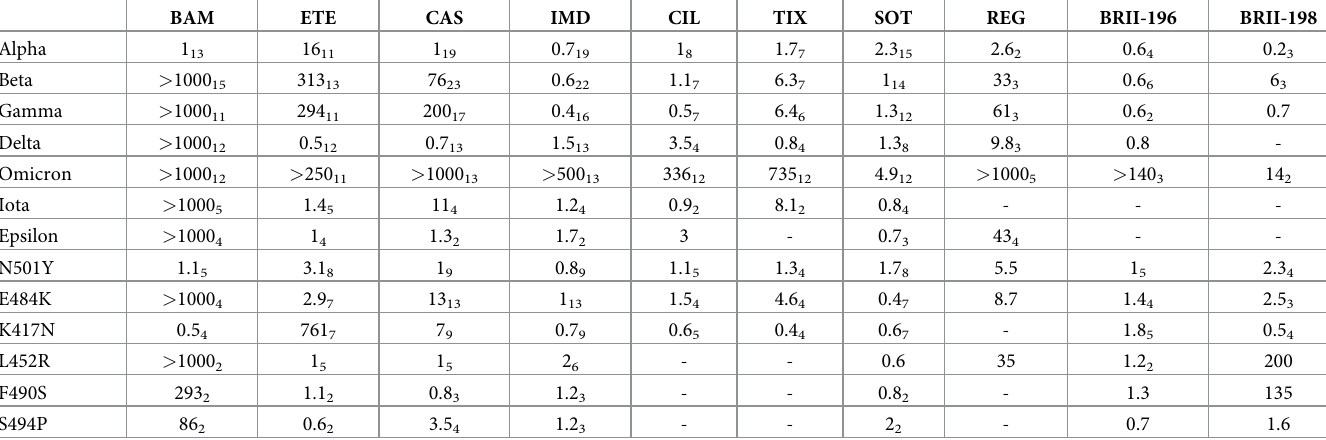
mAbs. In CoV-RDB, mAbs are characterized according to their stage of clinical develop- ment; spike target; and specific epitope, i.e., the list of amino acids within 4.5 angstroms of the mAb paratope, according to structural data obtained from the Protein DataBank (PDB). Table 3 lists those mAbs with FDA emergency use authorizations (EUAs) or that have been approved in one or more countries along with their spike targets and numbers of experimental results including in vitro selection and neutralization susceptibility data [18]. CoV-RDB con- tains 2,526 results for the ten mAbs in Table 3, 352 results for six additional investigational mAbs in clinical trials at the time of writing, and 6,512 results for 373 mAbs that are not in clinical development as of December 2021 [19]. For 64 of these 373 additional mAbs, structural data are available in the PDB. Table 4 summarizes neutralization susceptibilities for the seven most studied variants and the six most studied individual spike mutations to those mAbs that Table 4. Median fold reduced neutralization susceptibility of 6 variants and 6 spike mutations to 12 mAbs in advanced clinical development 1 .